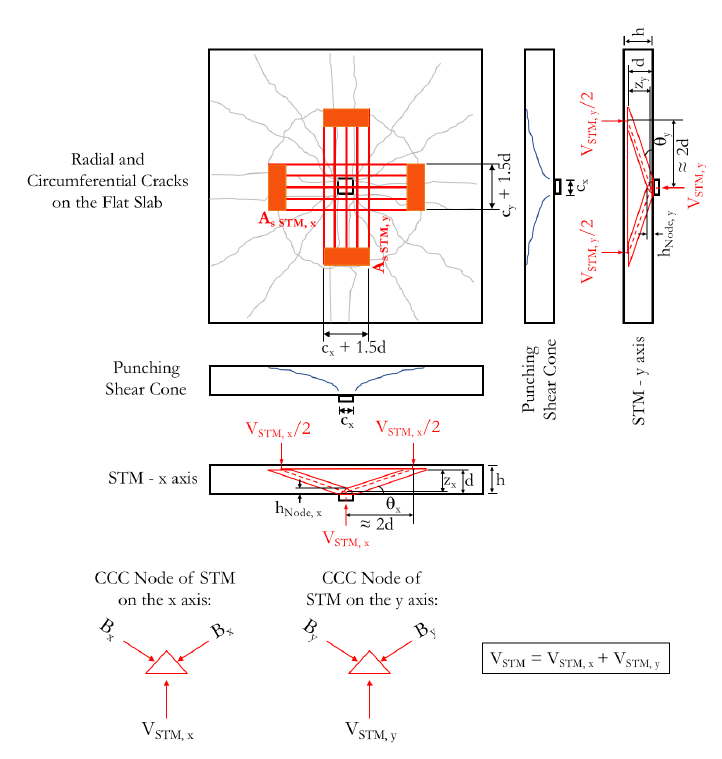
Figure 3. Strut and tie model